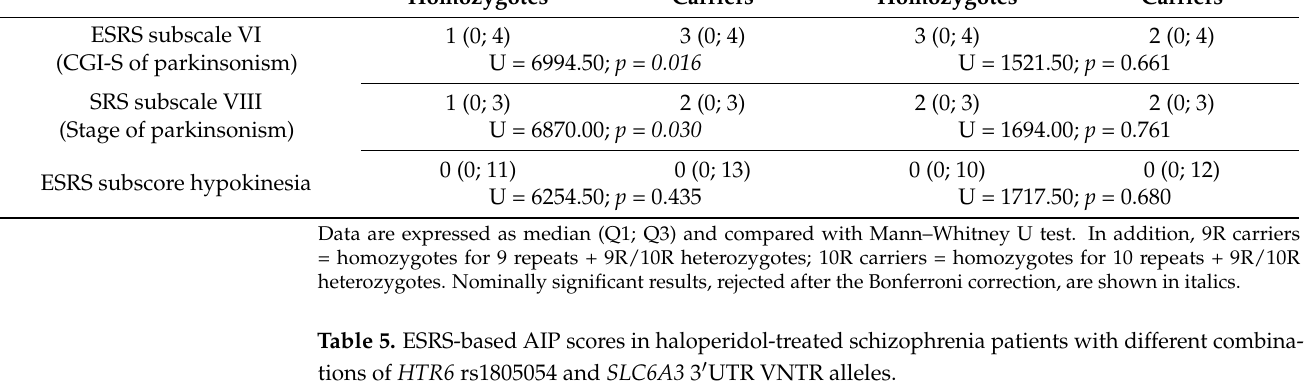
Table 5. ESRS-based AIP scores in haloperidol-treated schizophrenia patients with different